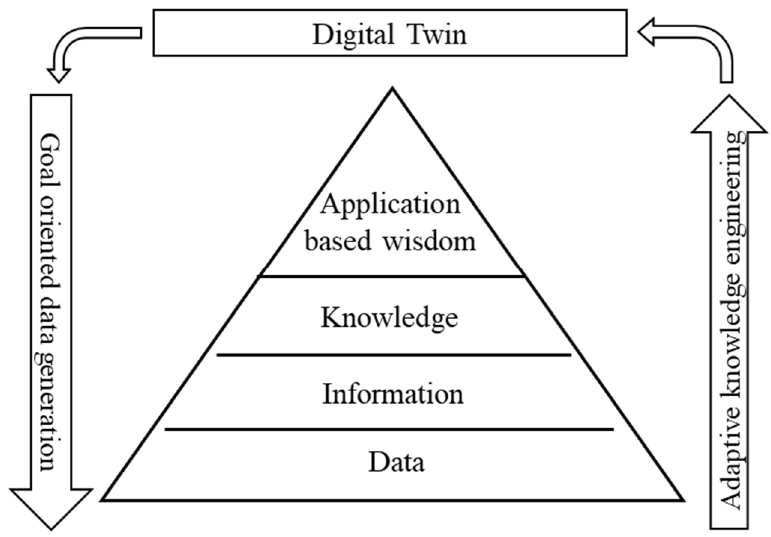
Figure 9. Digital Twin as a mean for knowledge generation and test bed for process understanding [101].